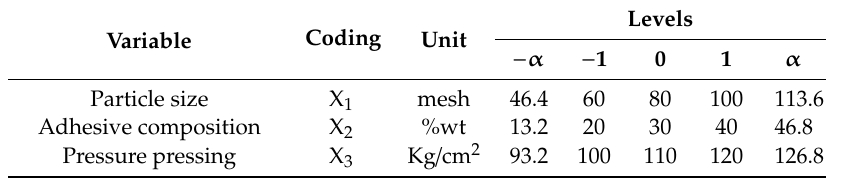
Table 1. Levels of the briquetting variables studied in this